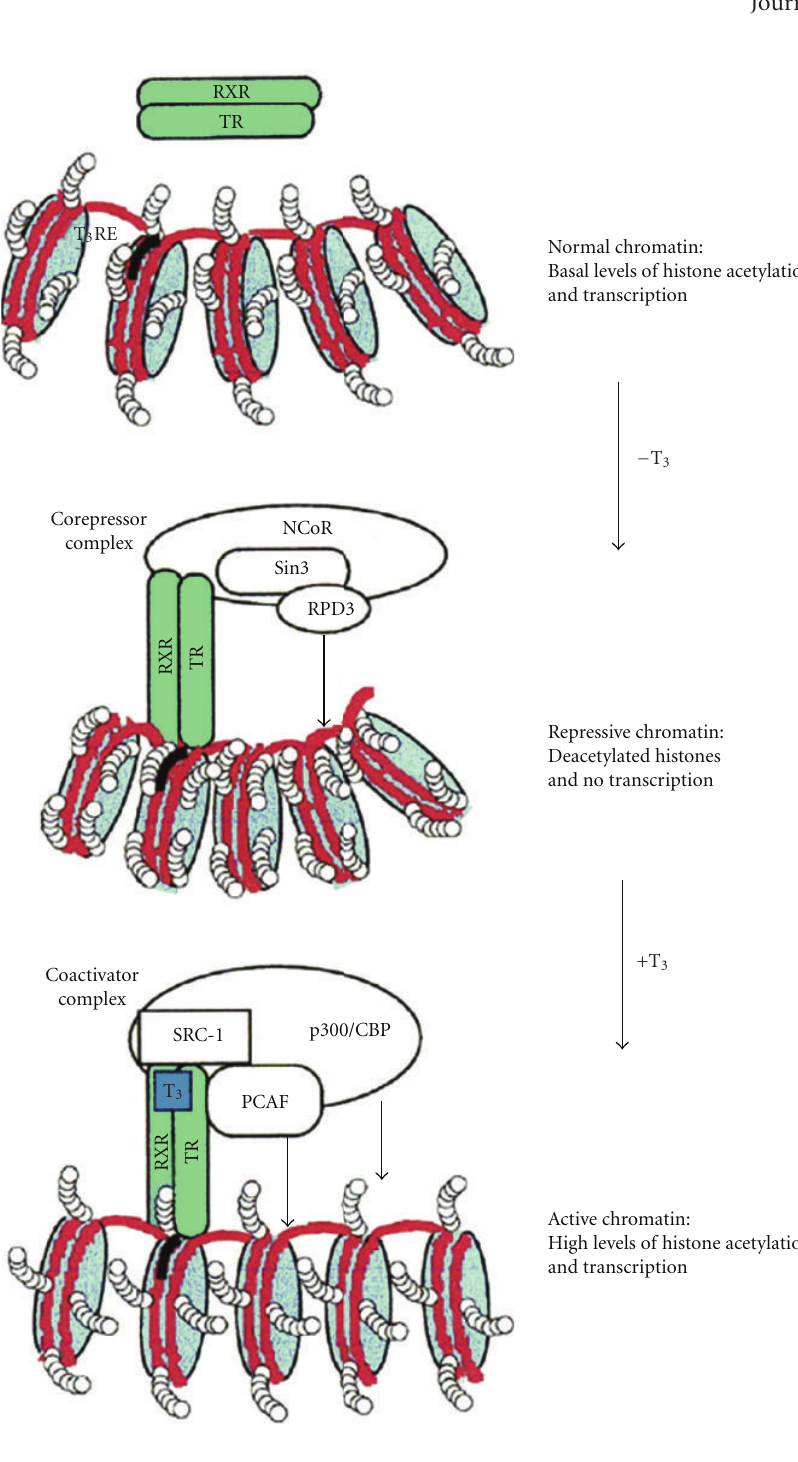
Figure 2: A representation by Wol ff e [8] of how a ligand-activated nuclear receptor could modify the higher-order structure of chromatin. The packaging of DNA into chromatin is visualized in three transcriptionally active states: normal, repressive, and active. In this example, the region of chromatin chosen contains the thyroid hormone receptor (TR)/RXR heterodimer, with or without its ligand triiodothyronine (T 3 ), bound to the thyroid responsive element (TRE) in the target gene. In normal chromatin, histone acetylation is at its basal level and so is the transcriptional activity. In the absence of T 3 (as during early stages of development), chromatin exists in its condensed and transcriptionally repressive form whereby the histones are in a largely deacetylated state with no transcription of the TR’s target gene. In the presence of T 3 , the chromatin is now active with elevated levels of histone acetylation and transcription. The other components are proteins that form “corepressor” and “coactivator” complexes with complexes with the TR/RXR receptor heterodimer. For more details, see